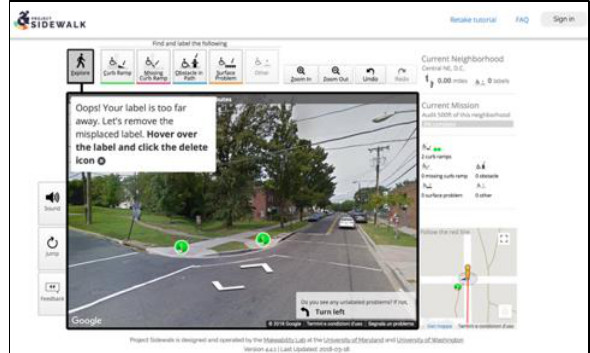
Figure 4. Screenshot of Project Sidewalk website. In this image is visible the user interface through which is possible to map the accessibility issues of the city sidewalks. Source: